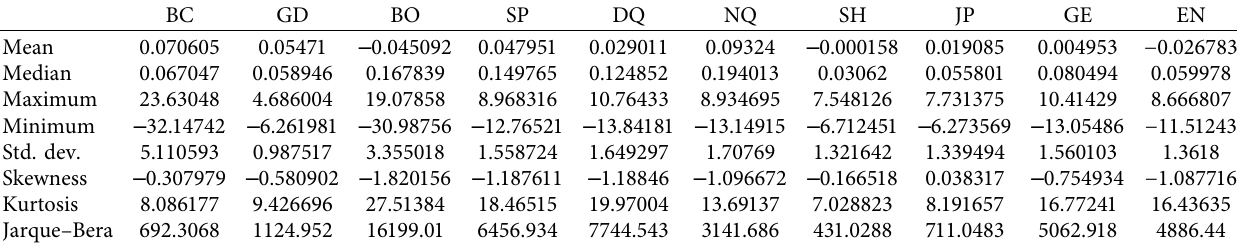
Table 1: Descriptive statistics.